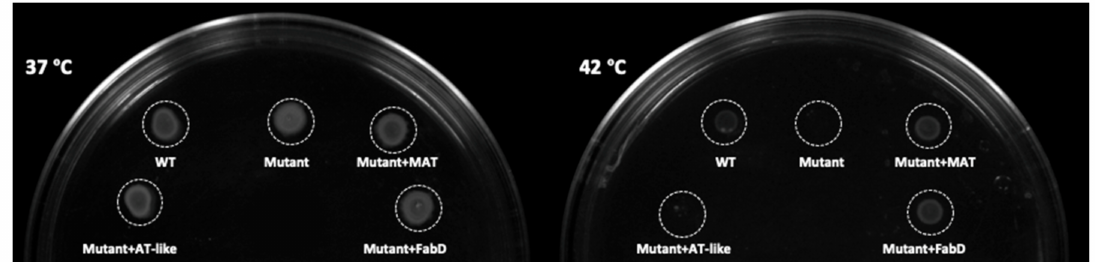
Figure 2. Plate complementation test of the AT-like domain in an E. coli fabD mutant grown at permissive (37 ◦ C) and non-permissive (42 ◦ C) temperatures. WT: parental wild type with the empty vector; Mutant: the mutant with the empty vector; Mutant+MAT: the mutant with authentic MAT domain from Subunit-A; Mutant+AT-like: the mutant with the AT-like domain from Subunit-B; Mutant+FabD: the mutant with E. coli wild-type MAT gene ( FabD